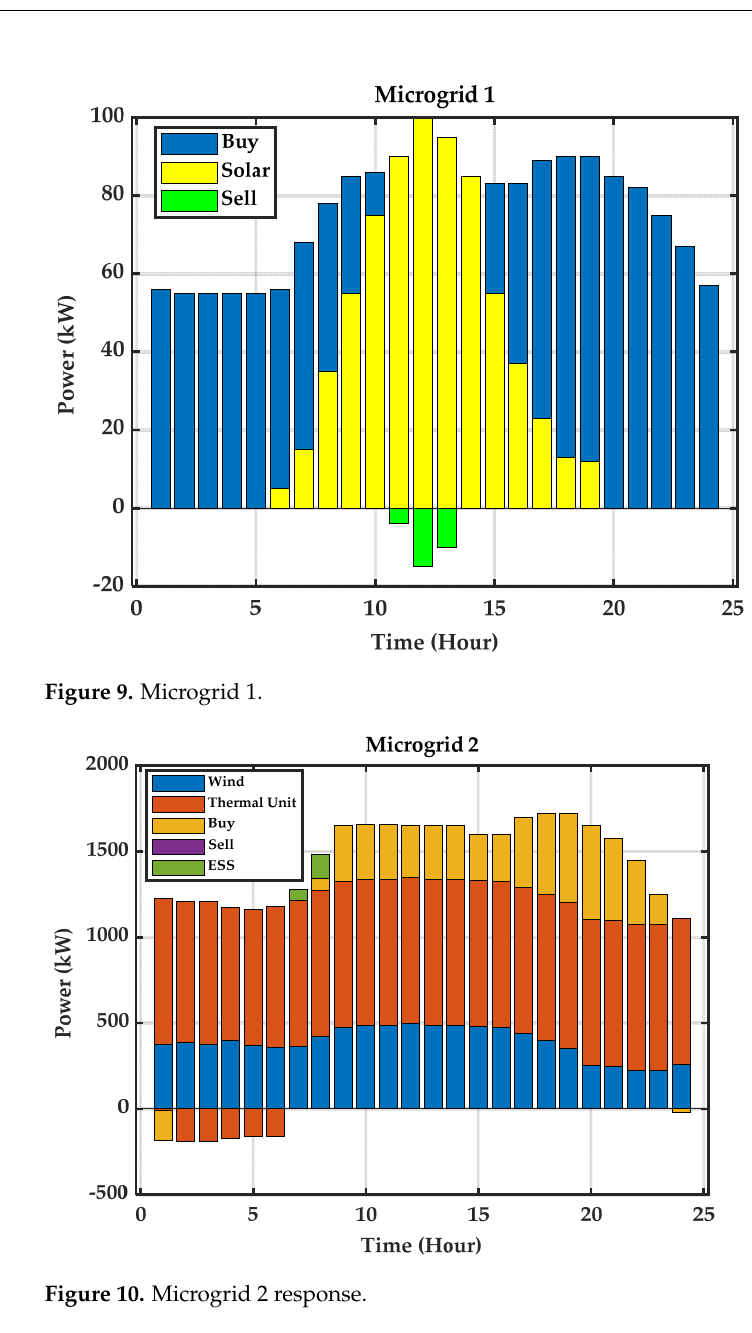
Figure 11. Microgrid 3 response.